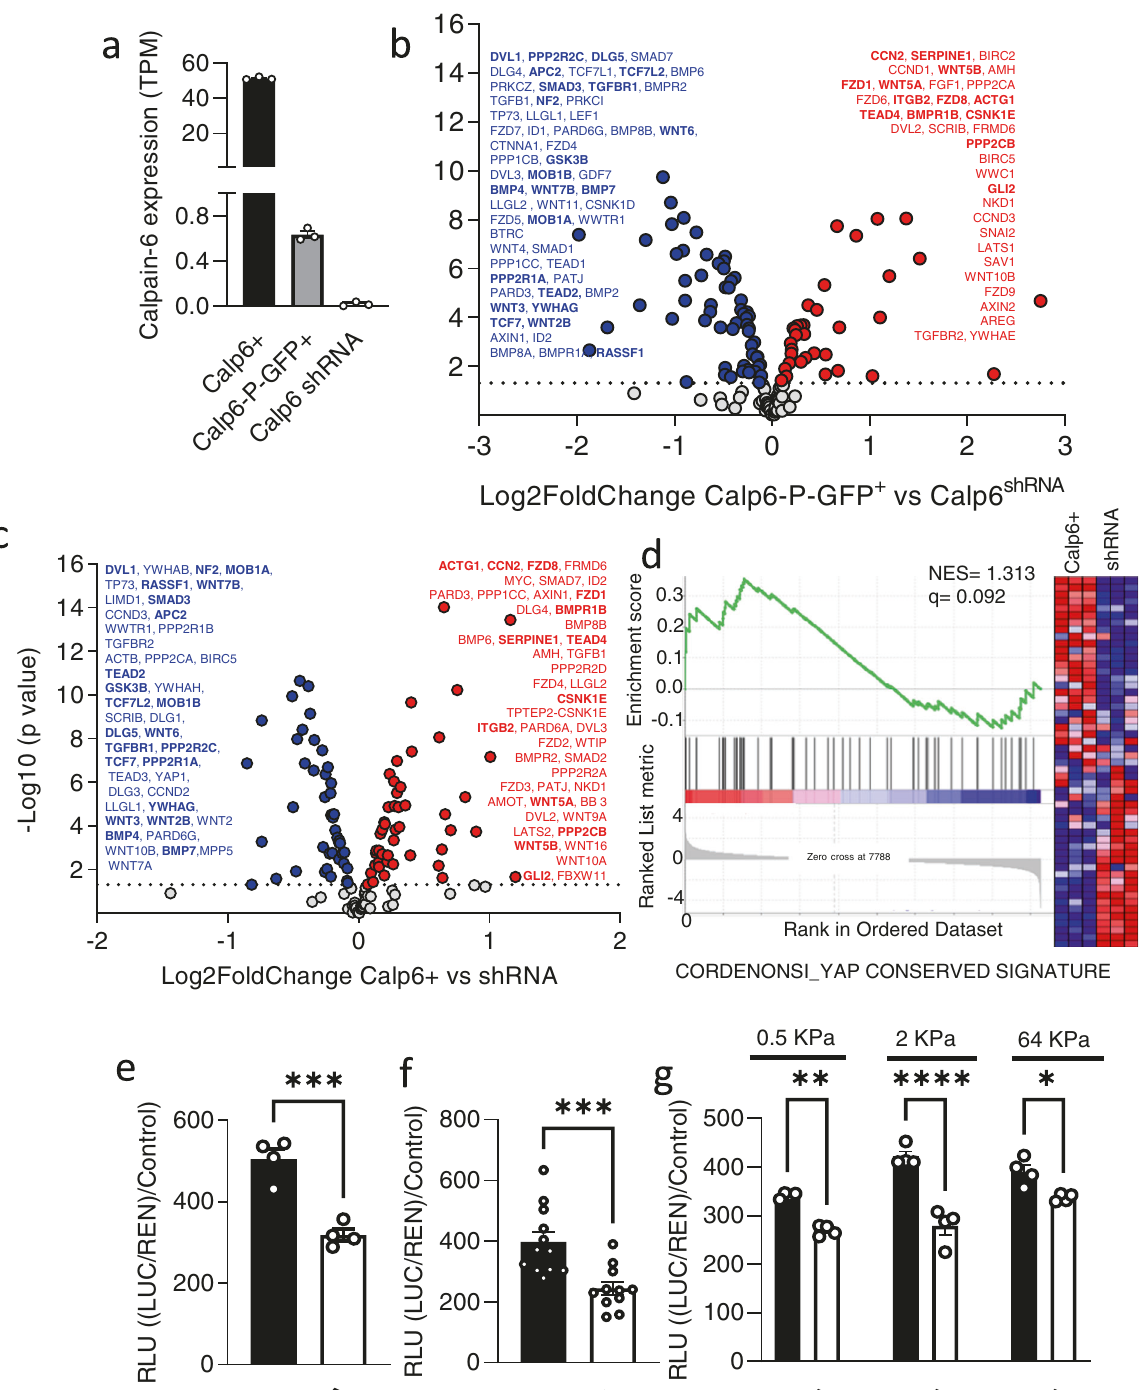
related to positive regulation of the G2M phase (Fig. 4c). Calpain-6 was also associated with the expression of genes of the G2M checkpoints (Fig. 4d). Flow cytometry analyses of Calp6-P-GFP + cells showed that the highest GFP expression was observed in cells in G2M (Fig. 4e). Moreover, GFP expression was increased in